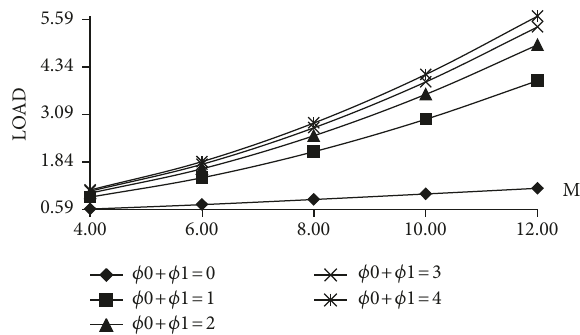
Figure 2: Variation of load carrying capacity with respect to M and 𝜙 0 + 𝜙 1 .